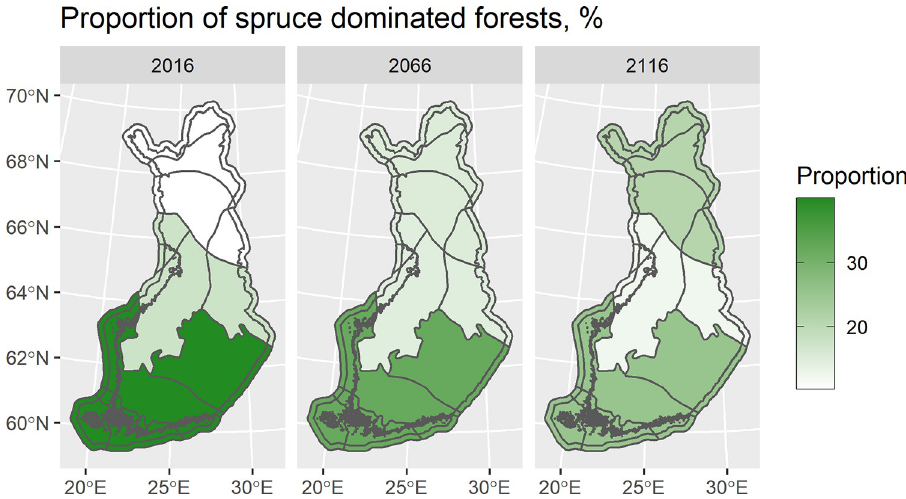
Fig 2. Proportion of spruce ( Picea abies ) -dominated forests in 2016, 2066, and 2116 by vegetation zones when climate change is assumed to affect the future tree species distribution [Bio-geographical regions / Source: Finnish Environment